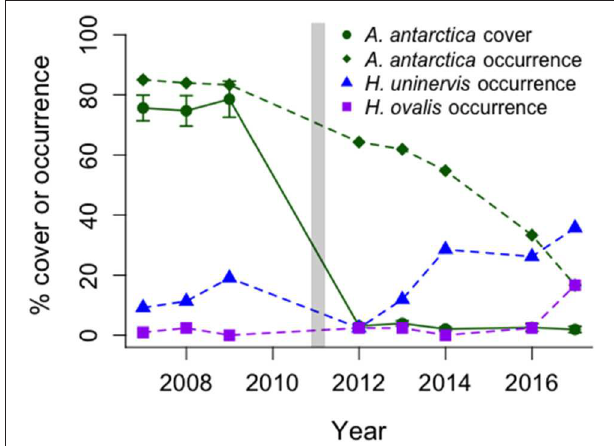
FIGURE 5 | Changes over time in occurrence of two common tropical seagrasses ( H. uninervis , H. ovalis ) and percent occurrence (as a total) and percent cover (mean ± SE, n = 63) of the dominant temperate seagrass, A. antarctica , before and after the MHW (vertical bar). Data collected from 42 long-term monitoring stations north of Monkey Mia, Shark Bay.